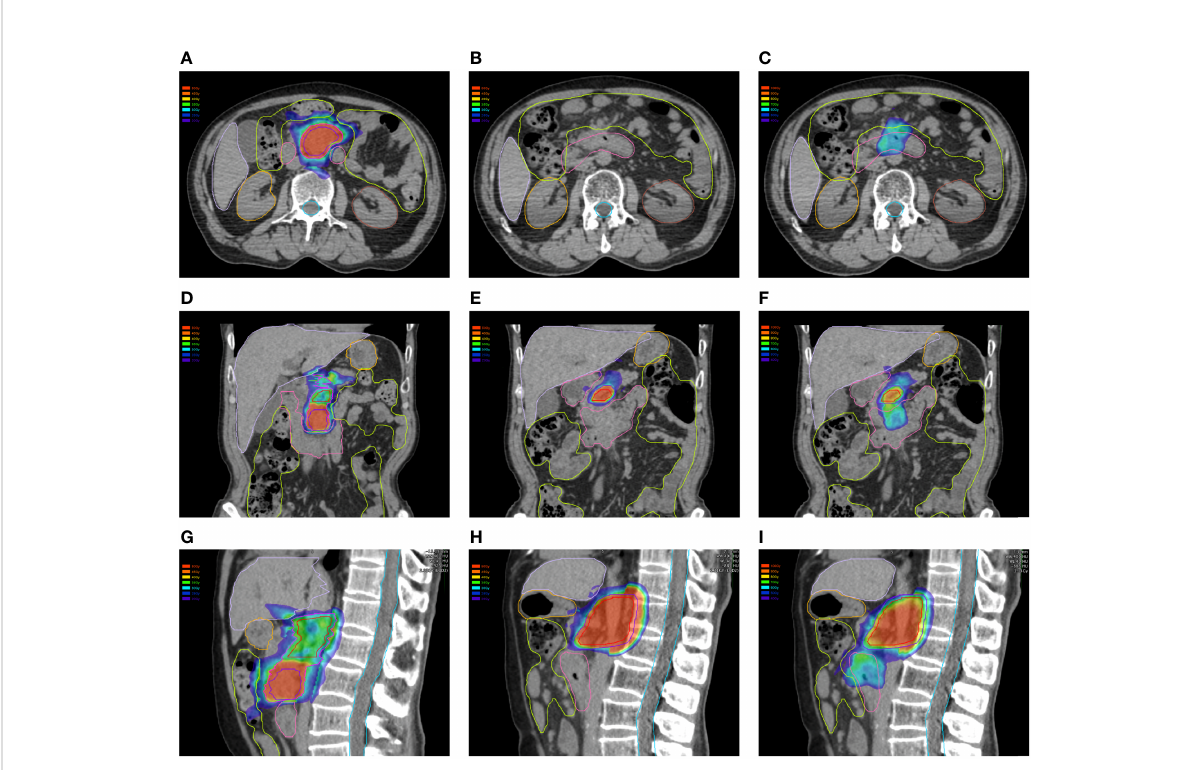
FIGURE 4 Dose distributions of the fi rst plan in the (A) horizontal plane, (D) coronal plane, and (G) sagittal plane. Dose distributions of the fi rst plan in the (B) horizontal plane, (E) coronal plane, and (H) sagittal plane. Dose distributions of the fi rst plan projected to the second CT scans in the (C) horizontal plane, (F) coronal plane, and (I) sagittal